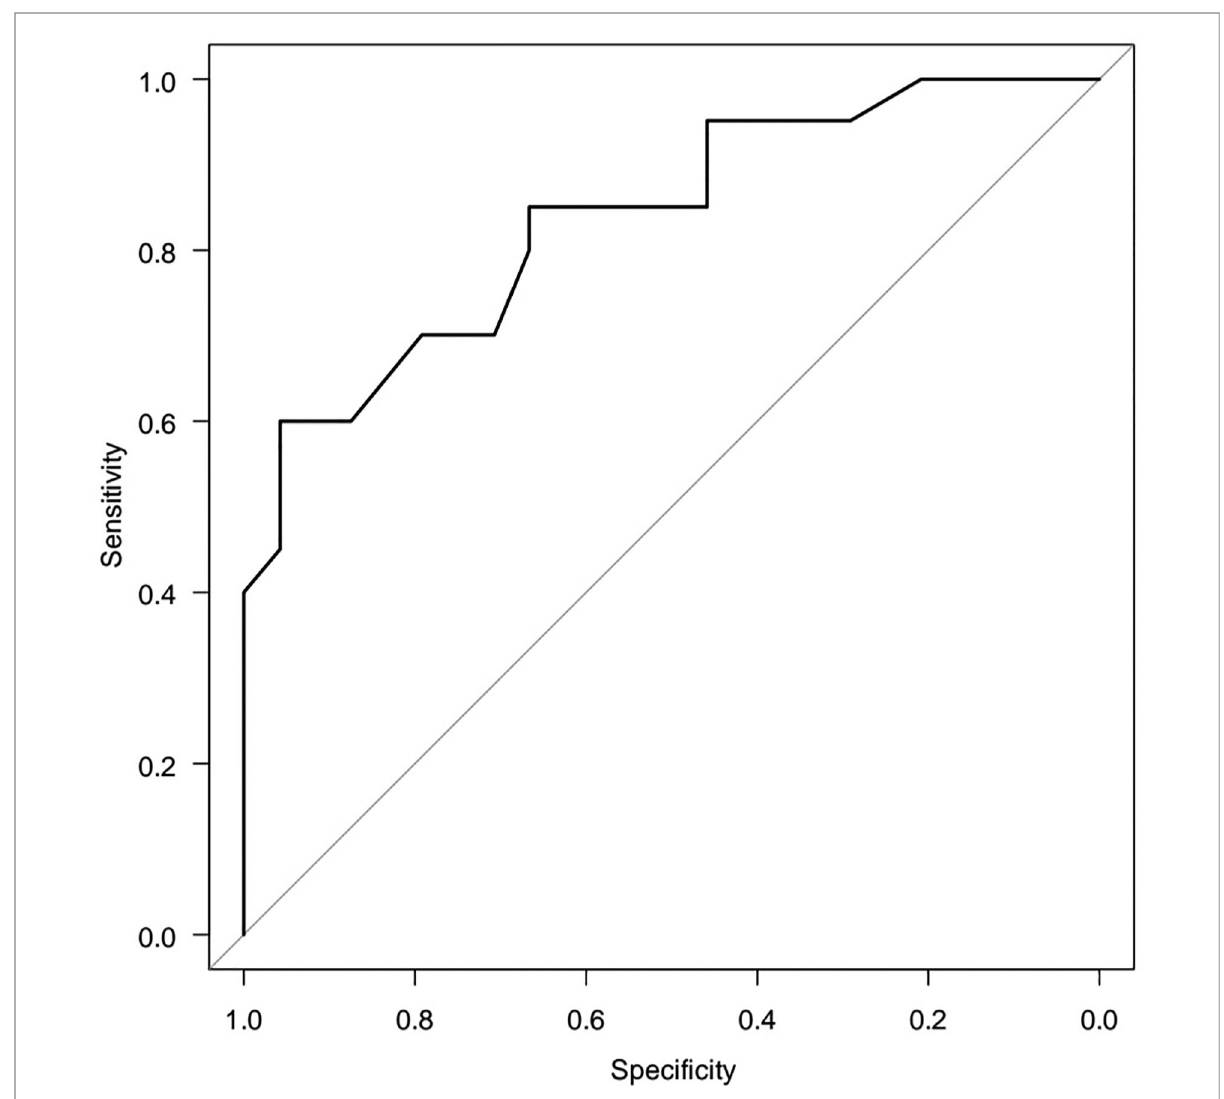
FIGURE 6 ROC-curve fi ve-factor logistic regression model (AUC=0.836 95% CI 0.717 –